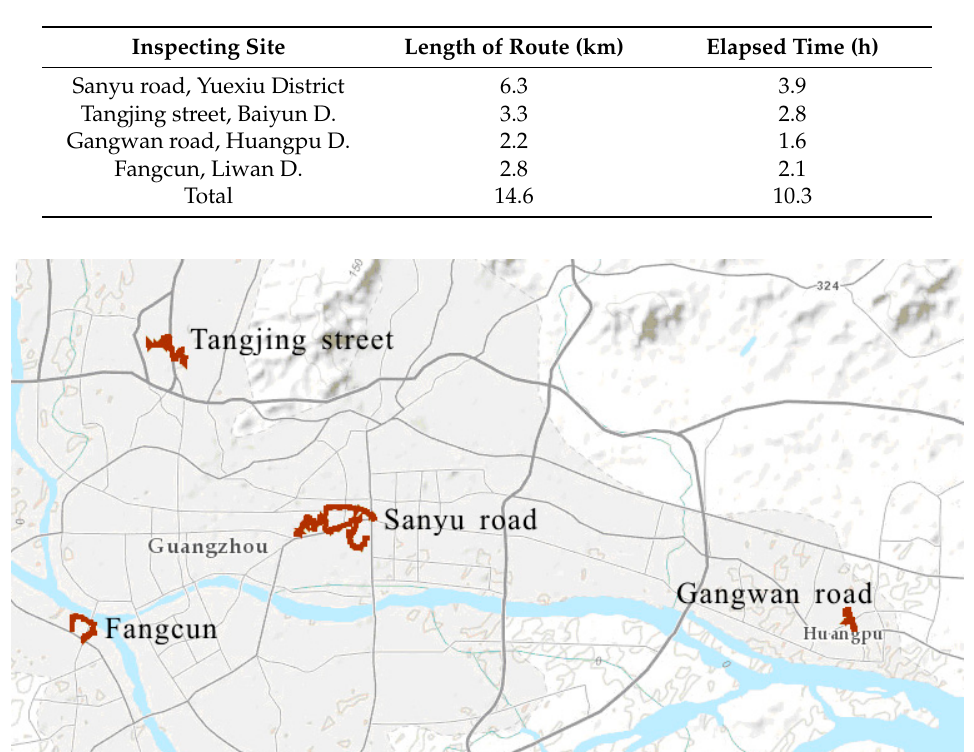
Table 1. Length of inspection route and elapsed time in the study sites in Guangzhou, China.